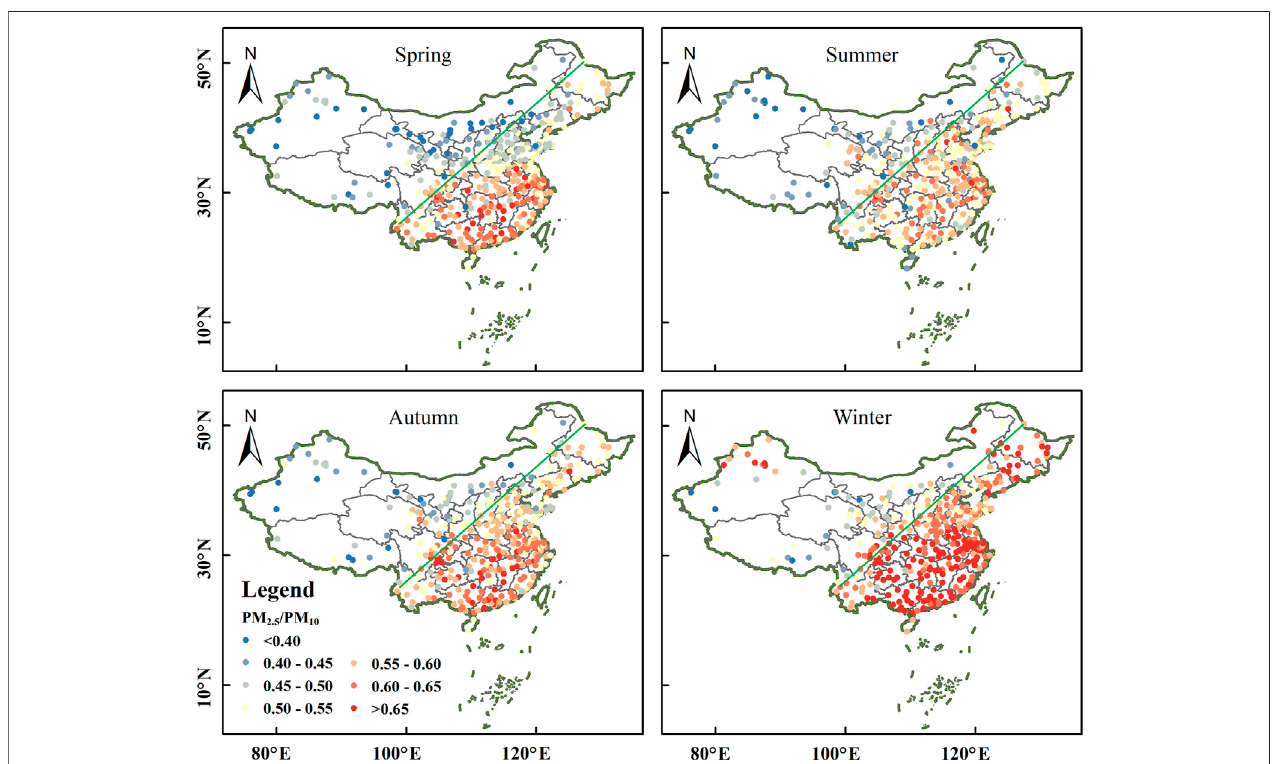
FIGURE 5 | The spatial distributions of averaged PM 2.5 /PM 10 ratios at national sites in China for four seasons of spring, summer, autumn and winter during the study period from 2015 to 2018. The green line represents the Hu-line.